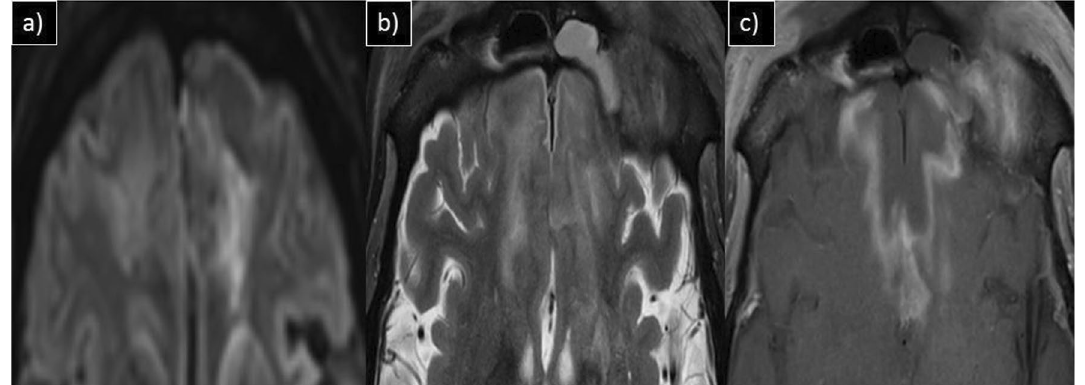
Fig. 5 a MRI axial iso-DWI, b axial T2W-FS and c axial post-contrast T1W-FS images of a 37-year-old male patient with complaints of headache and altered sensorium showing features of late cerebritis in bilateral frontal lobe. Left frontal sinusitis is noted